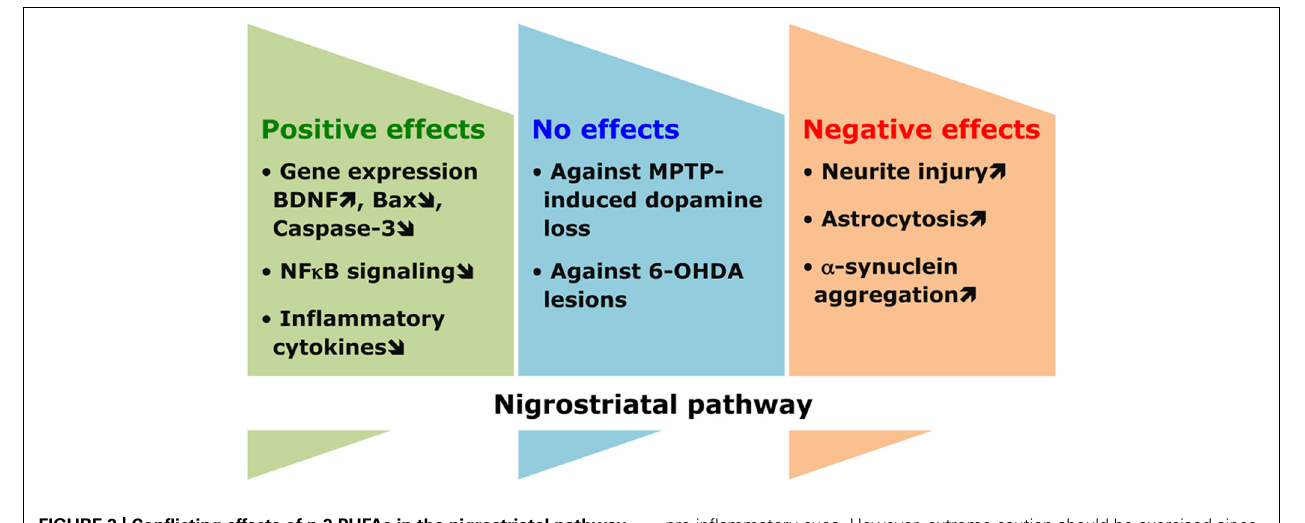
FIGURE 3 | Conflicting effects of n-3 PUFAs in the nigrostriatal pathway . n-3 PUFAs are commonly endowed with a wide range of helpful effects, as illustrated by the protective benefit that these fatty acids offer to dopaminergic neurons in the nigrostriatal tract against apoptotic and